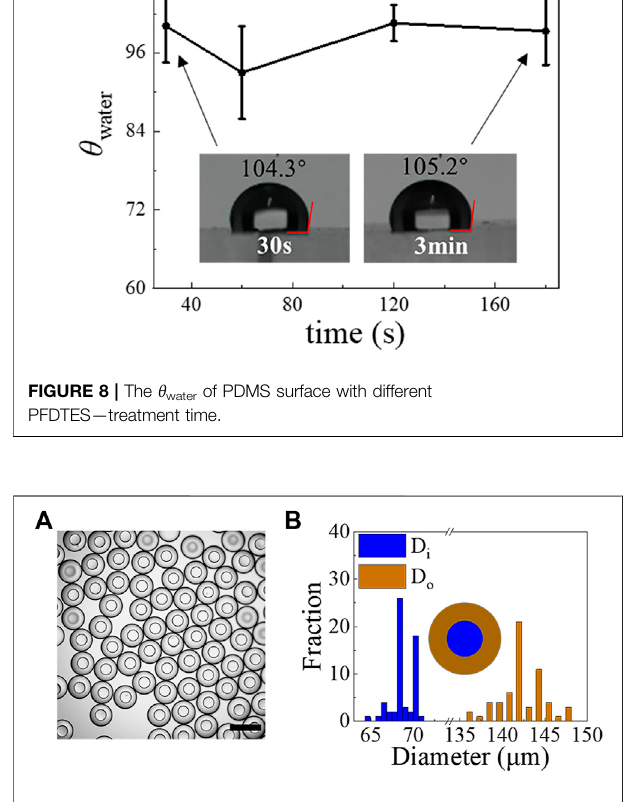
FIGURE 9 | (A) Optical image showing examples of microcapsules obtained from w/PDMS/w droplets using micro fl uidic devices whose channel surfaces were treated with PFDTES. Scale bar represents 200 μ m. (B) Size measurements of microcapsules generated under the conditions of Q i